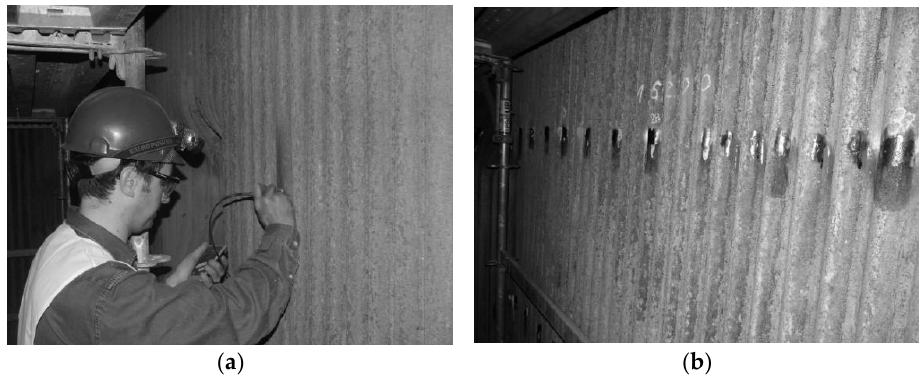
Figure 4. Measuring the tube thickness in the boiler with the aid of the ultrasonic method: ( a ) the measurement process; ( b ) the measurement points.